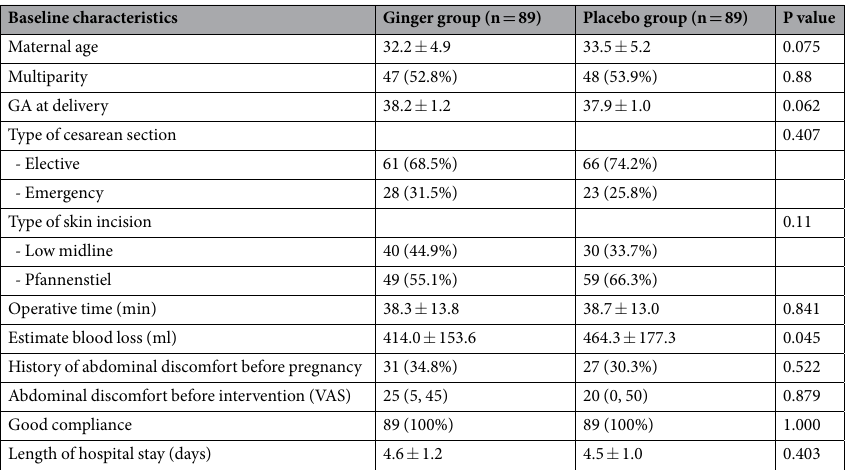
Table 1. Baseline characteristics. Data presented as mean ± SD, n (%) or median (interquartile range). VAS: visual analogue